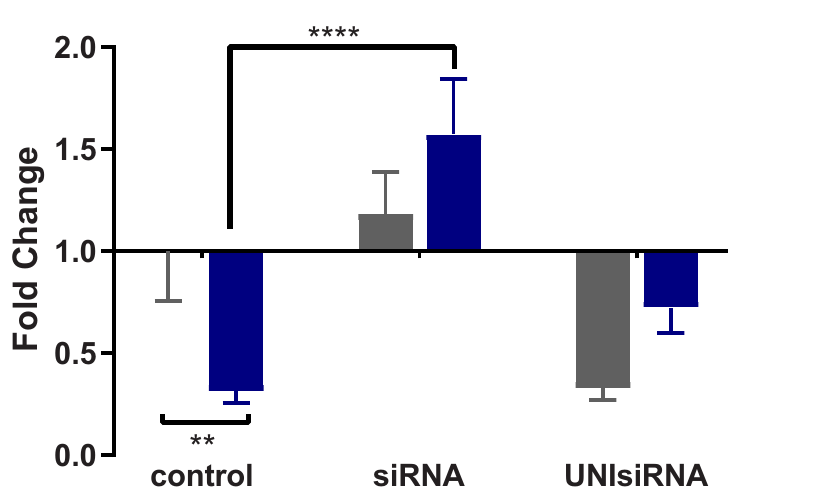
Fig 9. qPCR analysis of RNA from resistant BS-90 juvenile snails unexposed (gray) or exposed (blue) for 2hr to S . mansoni miracidia. Histograms show expression of the nimbusRT encoding transcript in normal BS-90 snails (control) or those transfected with BgPiwi siRNA. Note the down regulation of the nimbusRT encoding transcript in S . mansoni exposed control BS-90 snails and the upregulation of nimbusRT transcript in BS-90 (exposed and unexposed) snails transfected with BgPiwi siRNA where transcript encoding BgPiwi has been knocked-down (shown in Fig 2B). In BS-90 snails transfected with mock UNIsiRNA, note the down regulation of the nimbusRT encoding transcript in exposed snails similar to that observed in control exposed snails. Fold change was determined as described in MATERIALS and METHODS. Significant expression normalized against expression of the myoglobin encoding transcript was measured by 2-way ANOVA and is indicated by number of asterixis on each histogram where ���� , indicates the most significant value p � 0.0001, ��� p � 0.001, �� p � 0.01, � p � 0.05, ns p > 0.05.